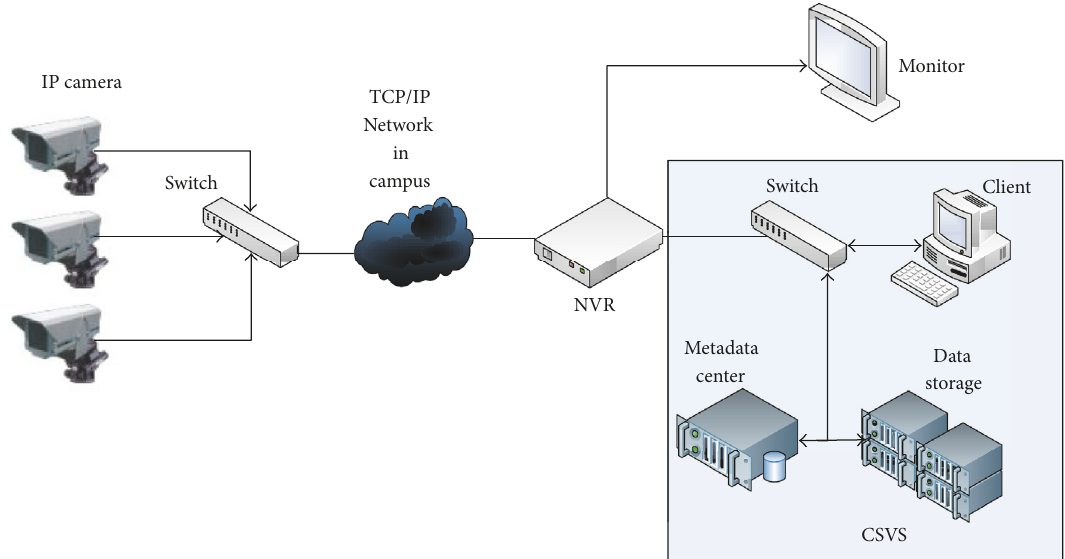
Figure 1: Video surveillance system deployment and the position of CSVS